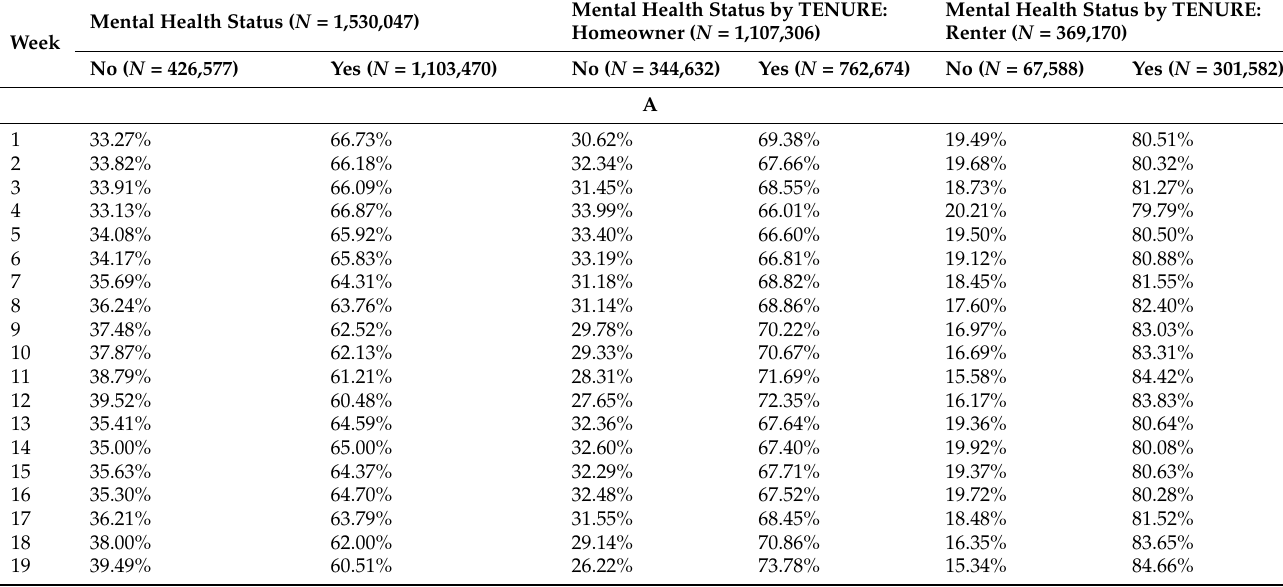
Table 4. ( A ) Weekly percent distribution of mental health concerns during pandemic, overall sample and by tenure status. ( B ) Mental health concerns during pandemic, by living